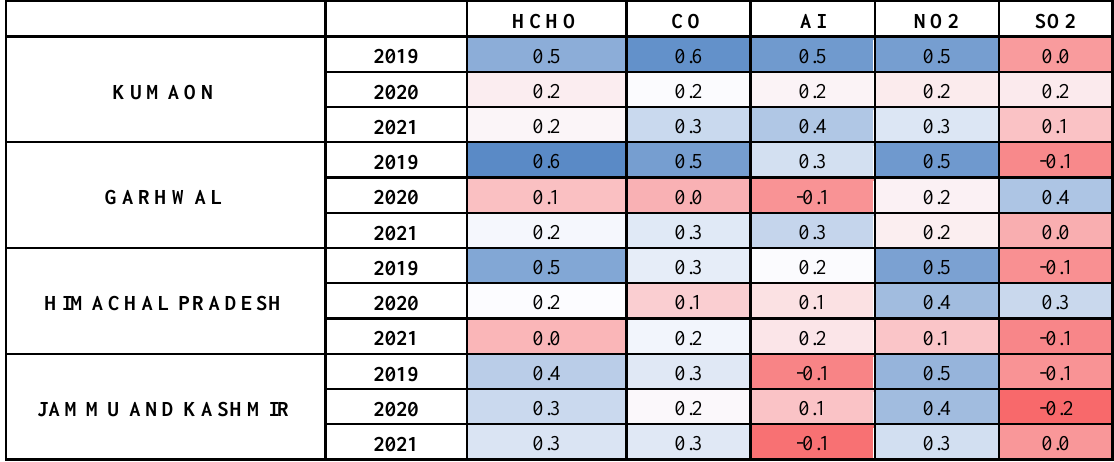
Table 2. Correlation values for all the gases with four region’s fire